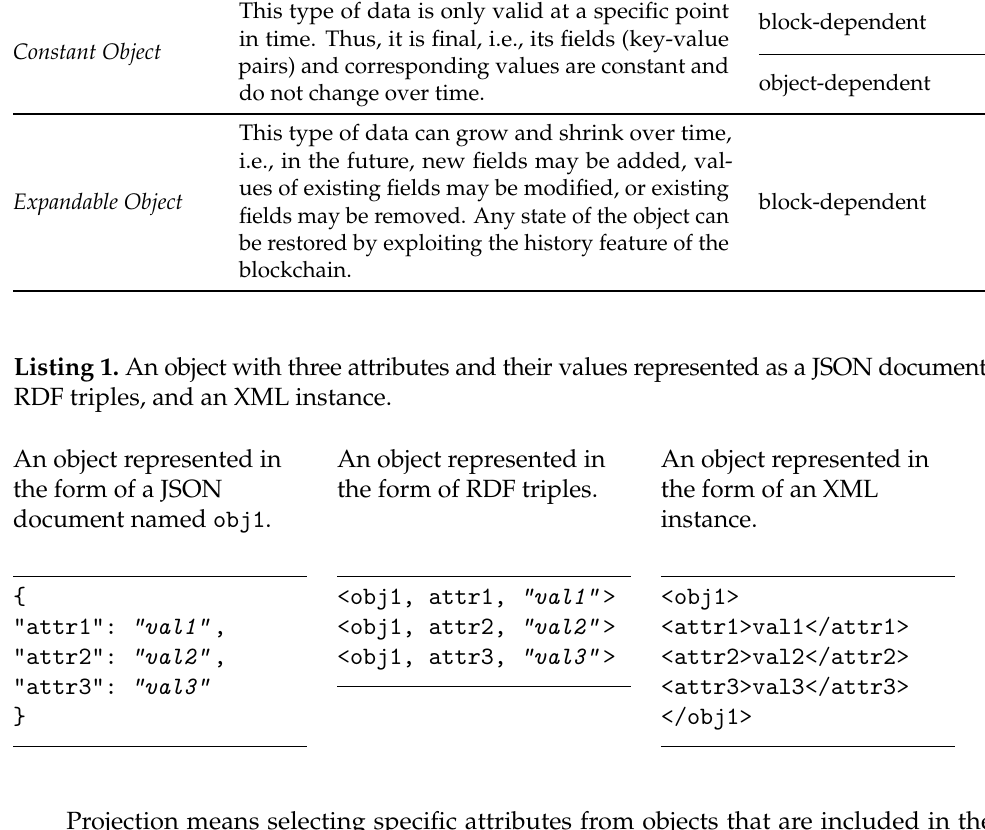
Table 2. The two types of objects which are relevant in the context of blockchains. Type of Data This type of data is only valid at a specific point Constant Object